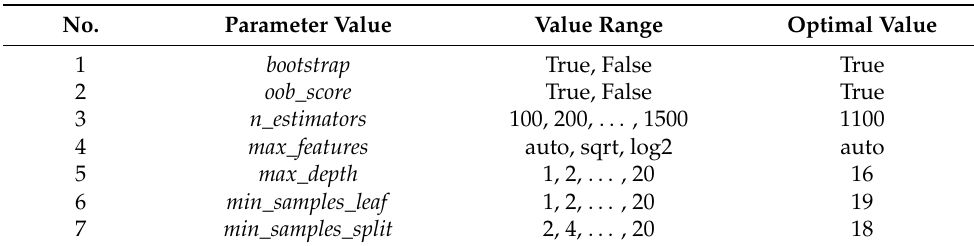
Table 4. Optimal values of model